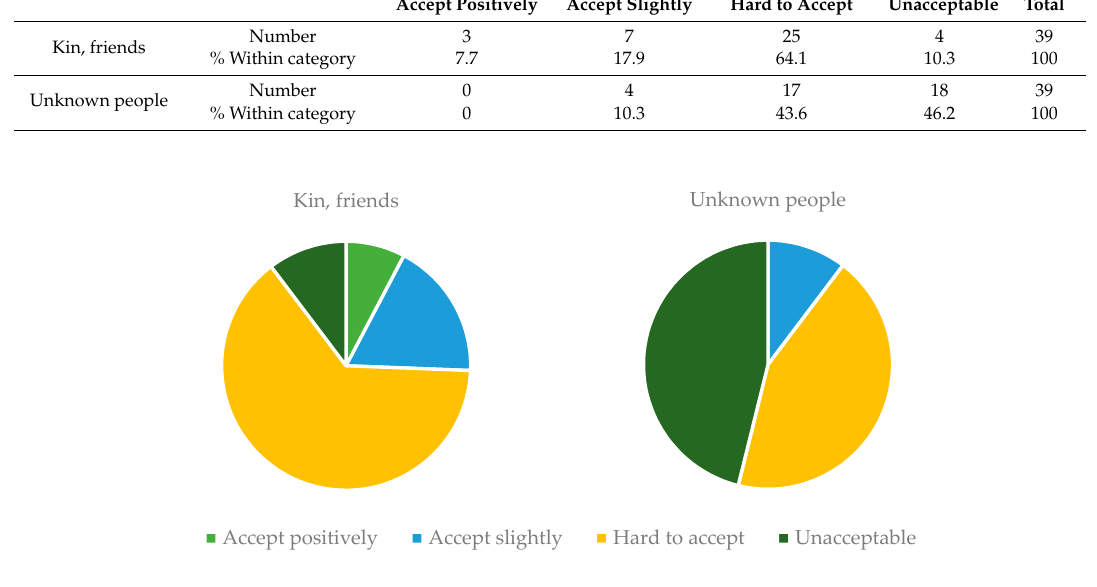
Figure 6. Proportion of migrant